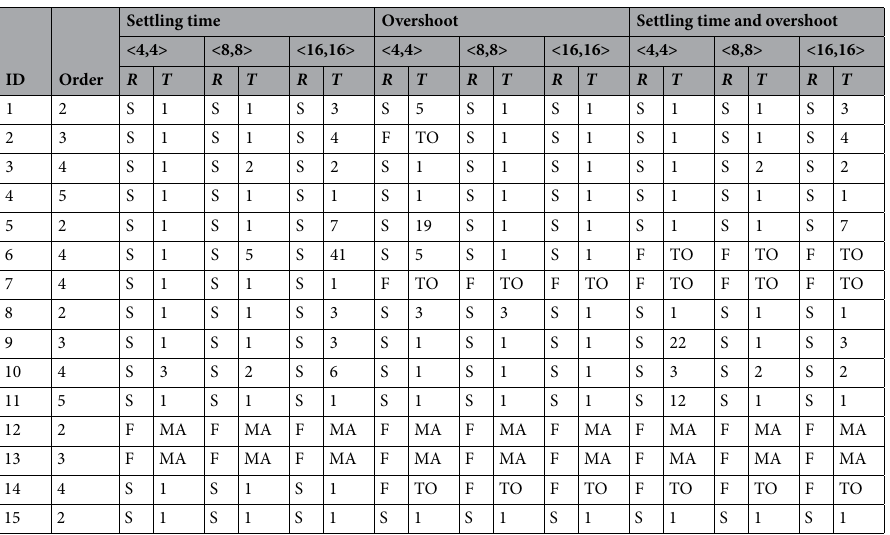
Table 1. We show the experimental results considering settling time and overshoot specifications. ID identifies each benchmark, Order indicates the number of continuous variables, R represents the result of the associated synthesis (successful or failed), T is the number of attempts to perform a synthesis procedure, MA means the maximum number of attempts has been reached, TO indicates that there was time-out during a specific execution, S means synthesis successful, F means synthesis